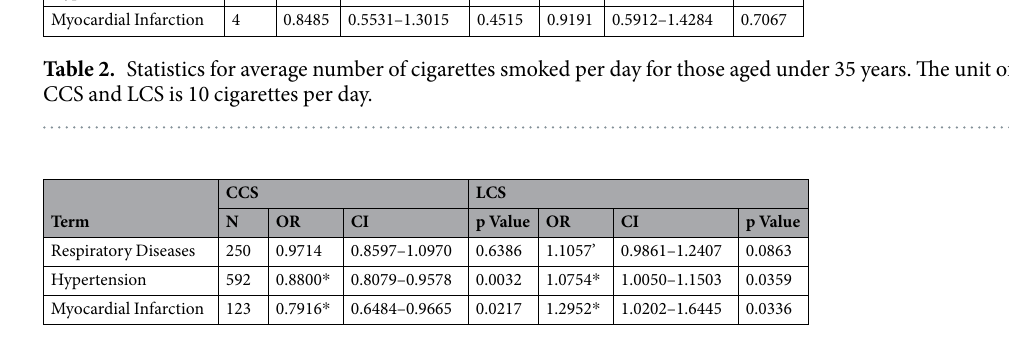
Table 3. Statistics for average number of cigarettes smoked per day for those aged between 36 and 55 years. ‘ * ’Indicates p < 0.05. Results that approach significance are indicated with the symbol ‘”. The unit of CCS and LCS is 10 cigarettes per day.